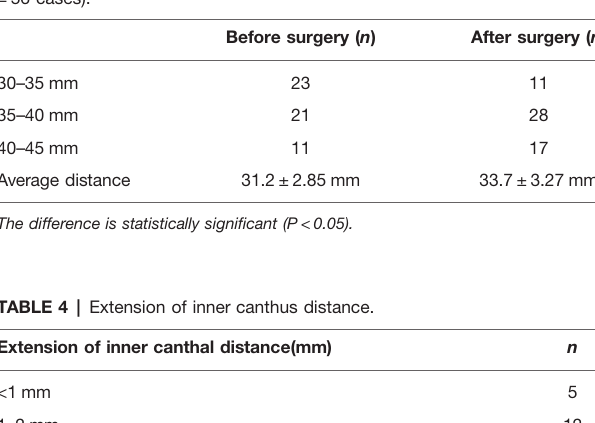
TABLE 3 | Comparison of internal canthal distance before and after surgery ( n =56 cases).